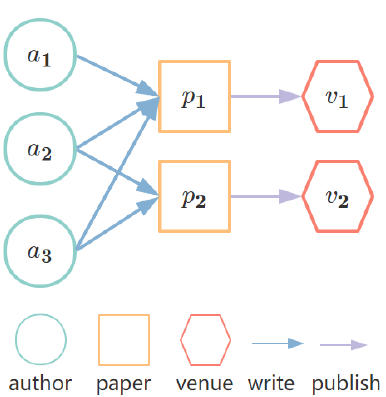
Figure 1. A small example abstracts from DBLP information